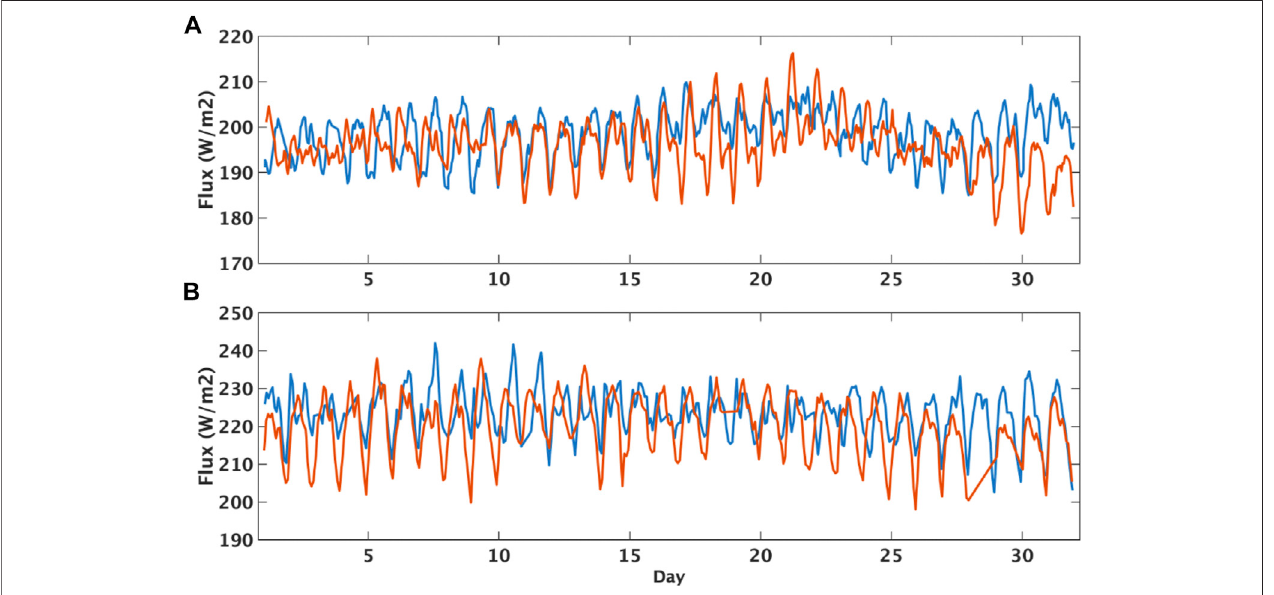
FIGURE 10 | Comparison of global daytime mean EPIC shortwave fl uxes between 2017 and 2020 for (A) May and (B) December. Blue lines are for 2017 and red lines are for 2020.